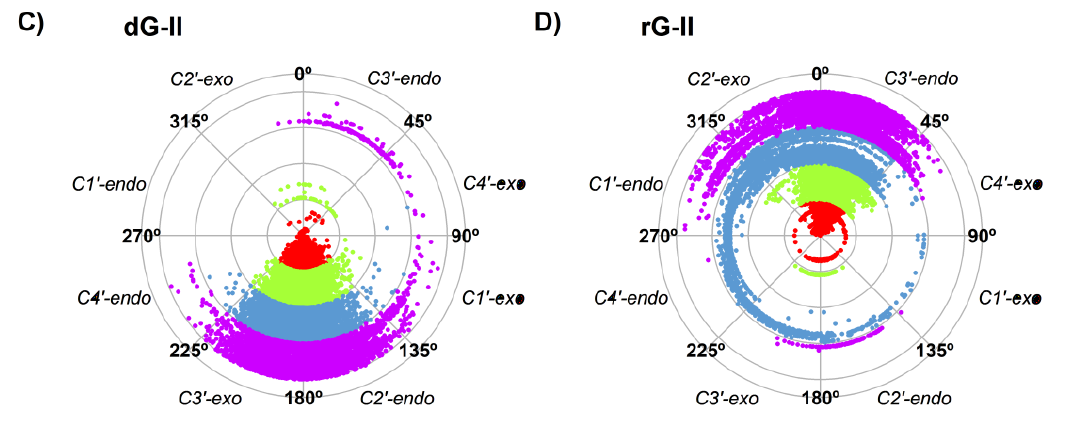
Figure 3. Sugar pucker of dG ( A , C ) and rG ( B , D ) ligands of 2′-dG-I ( A , B ) and 2′-dG-II ( C , D ) riboswitches systems. Each color in the plot represents a different replicate.